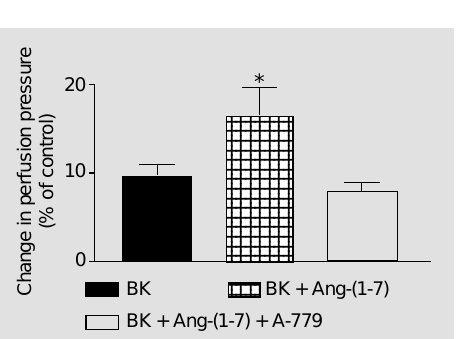
Figure 2 - Effect of indometha- cin (Indo) and L-NAME on the bradykinin-potentiating activity of Ang-(1-7) in isolated rat hearts. Indomethacin (5 mg/kg, ip ), L-NAME (30 mg/kg, ip ) or indomethacin combined with L- NAME at the same doses as indicated above were adminis- tered 1 h before animal sacri- fice. The effect of bradykinin (2.5 ng) was determined before and after perfusion with Ang-(1- 7) (2.2 nM). *P<0.05 compared to values obtained before perfu- sion with Ang-(1-7) (Student t - test).